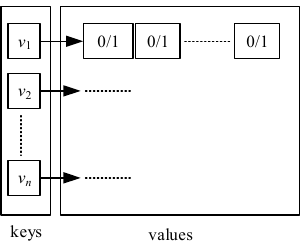
Figure 2. An example of key-vale pair table.